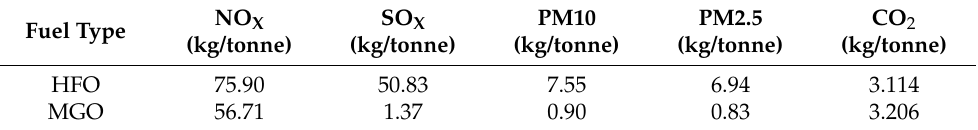
Table 1. The emission factors.